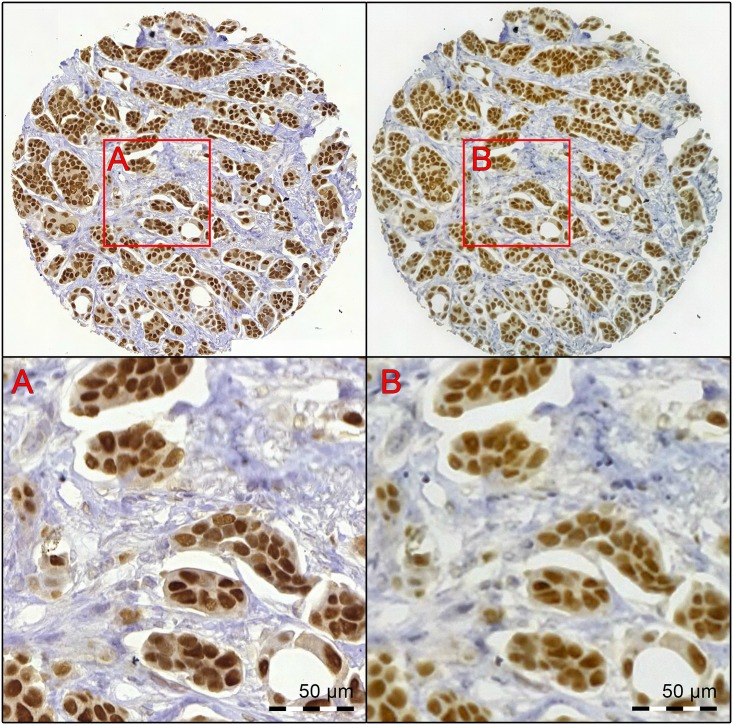
A breast cancer core biopsy, immunostained for estrogen receptor-alpha digitized with both imaging devices.The virtual sample has been digitized with the reference slide-scanner (left) and the point-of-care microscope (right). Regions marked with red bounding boxes represent tiles extracted for analysis. These can be seen at higher magnification in the lower part of the image (A. Reference slide-scanner B. Point-of-care microscope).